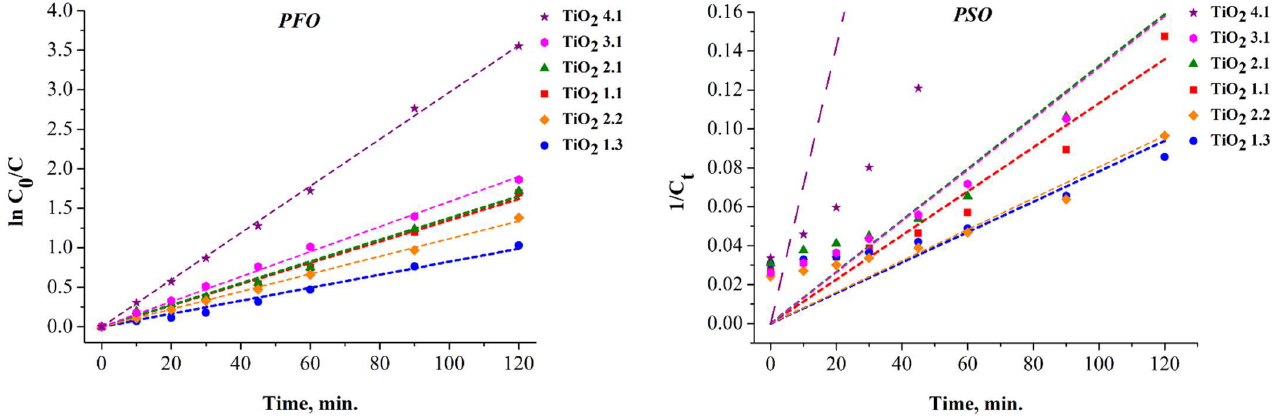
Figure 8. Pseudo-first-order and pseudo-second order photodegradation reaction of CR dye onto titania nanomaterial synthesized under different ultrasonication